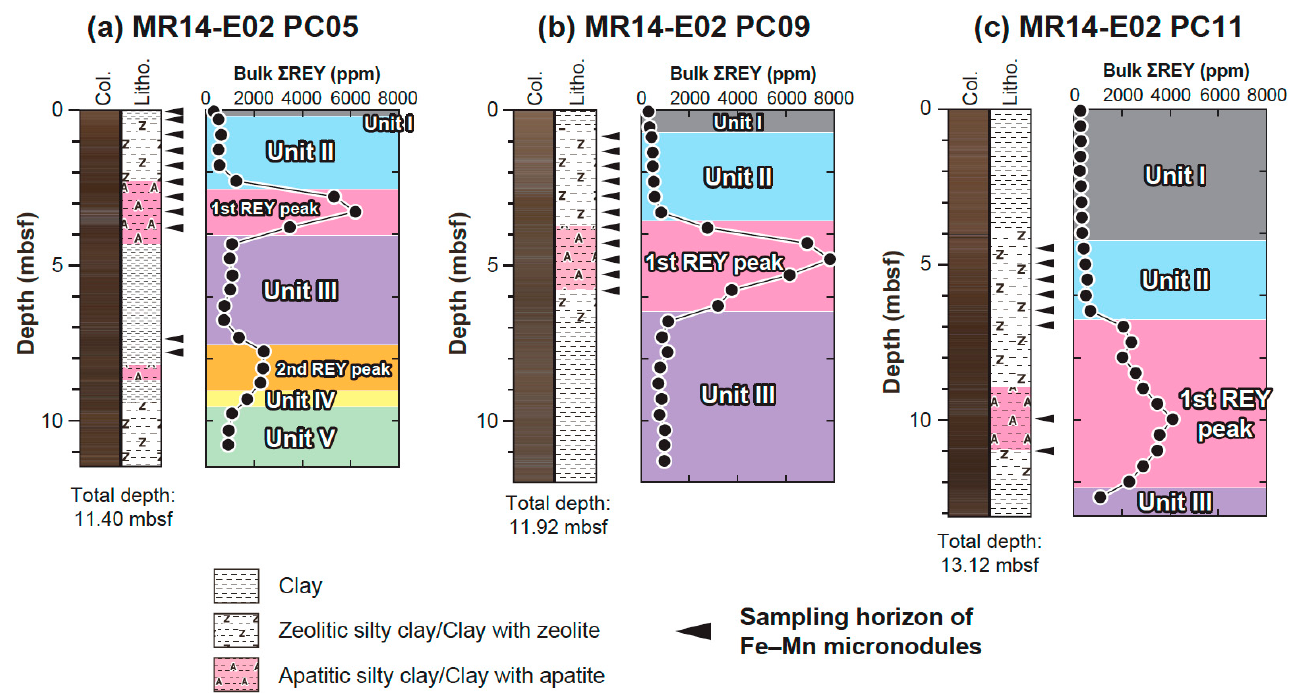
Figure 2. Lithostratigraphic and chemostratigraphic information about the studied cores. The sediment color, lithology, and chemostratigraphic units were obtained from [35]. The total rare-earth element and yttrium ( Σ REY) contents in bulk sediments were taken from [13]. The black triangles indicate the horizons from which Fe–Mn micronodules were collected [37]. Col.: sediment color; Litho.: sediment lithology; mbsf: meters below seafloor.